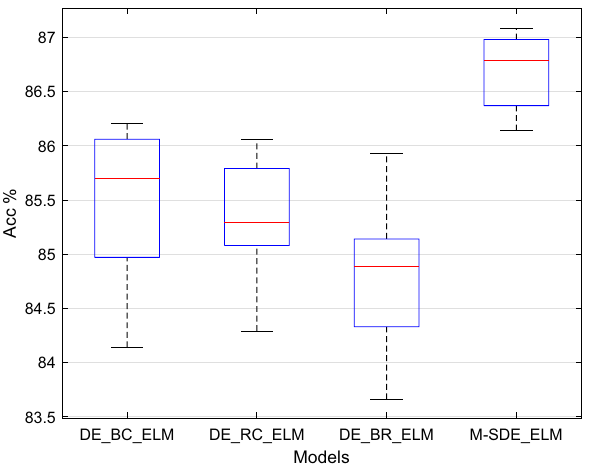
Figure 12. Comparison dual-strategy with multi-strategy